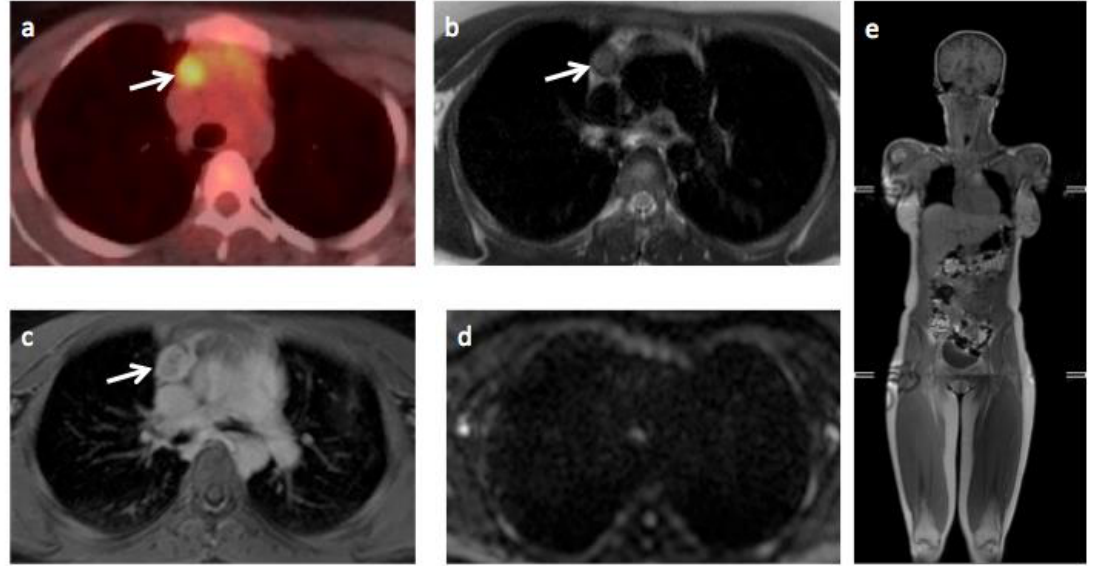
Figure 5. Images of a 22-year-old female patient with stage II Hodgkin’s lymphoma. Patient had left supraclavicular nodal disease (not shown here) and mediastinal disease. ( a ) Fused 18 F-FDG PET-CT DWI b 1000 ( b ) T2-TSE and ( c ) contrast-enhanced water-only mDixon showing the mediastinal disease (arrows). Mediastinal disease was not evident in ( d ) DWI b 1000 and ( e ) pre-contrast in-phase mDixon resulting in under-staging of disease.